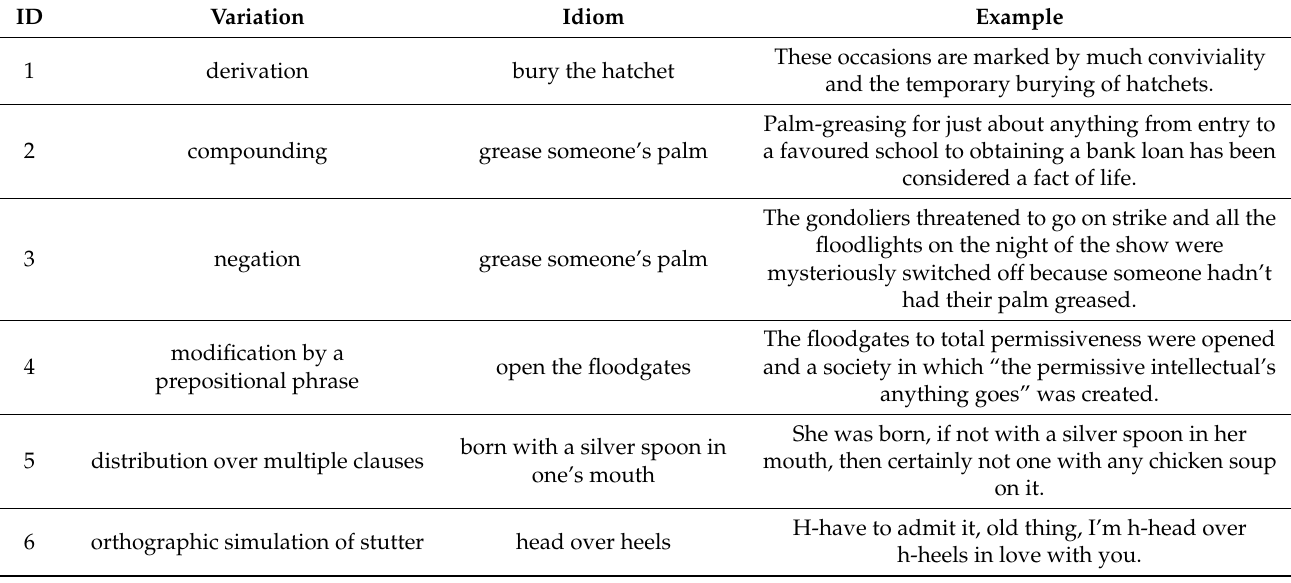
Table 2. Other types of idioms variation